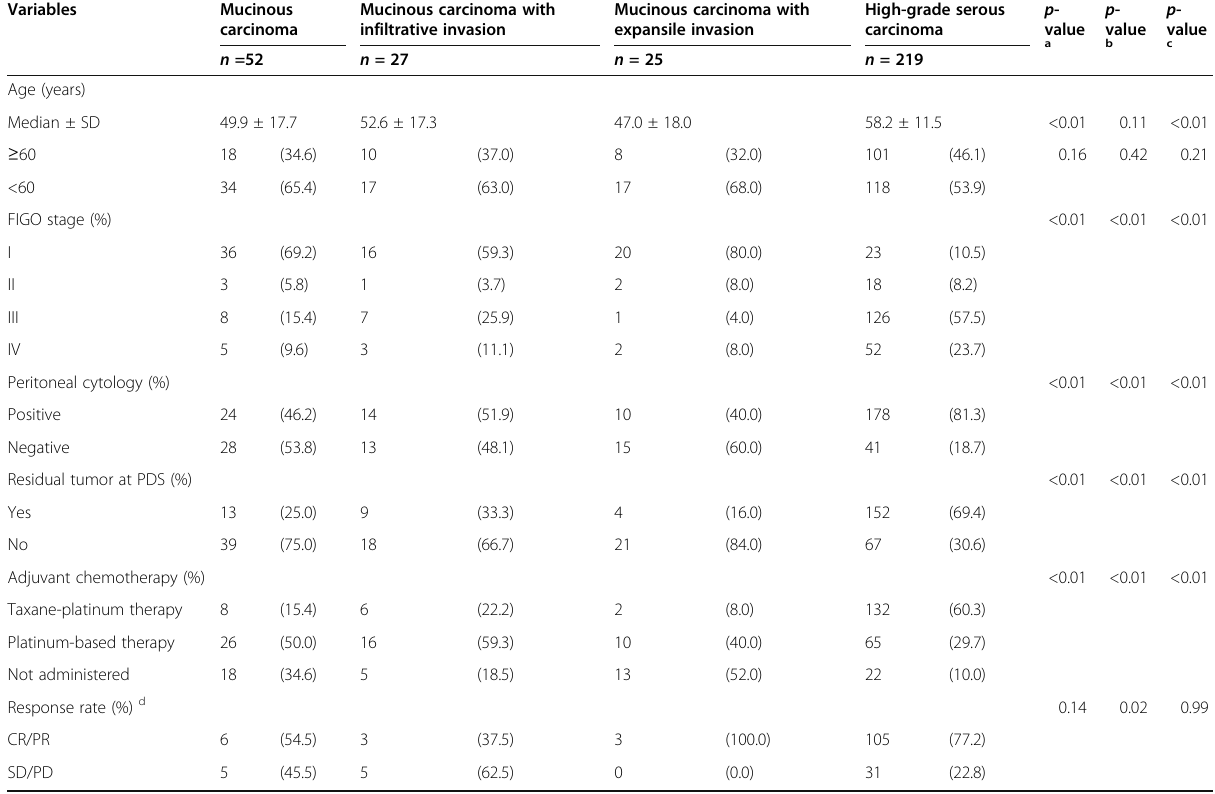
Table 1 Characteristics of cases of mucinous carcinoma and high-grade serous carcinoma